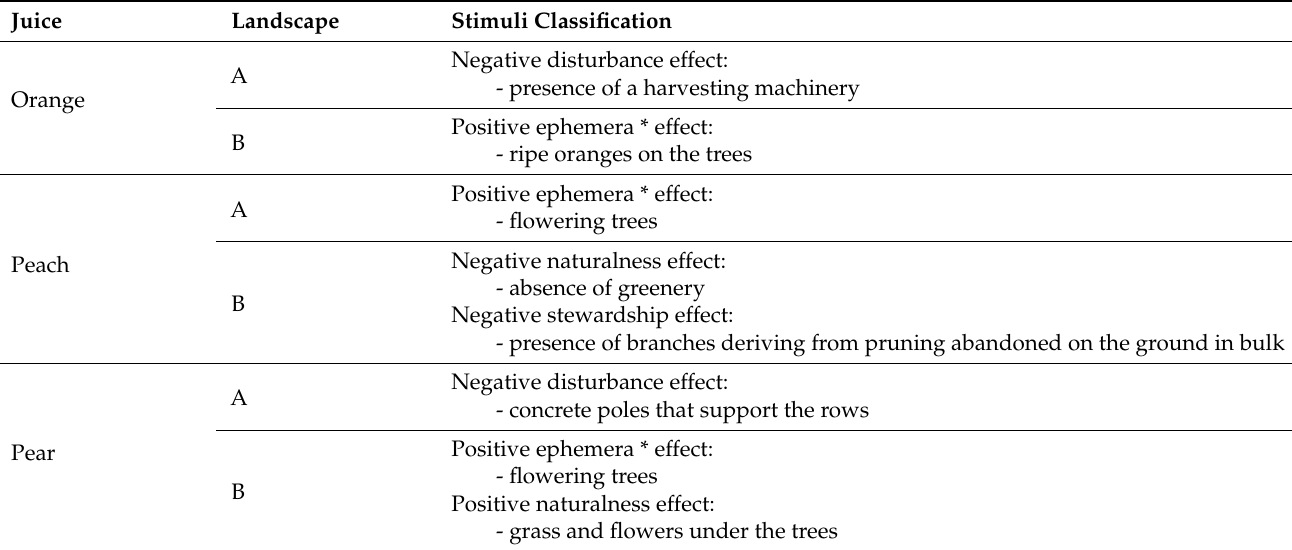
Table 1. Landscape stimuli classification according to Tveit et al. [23].